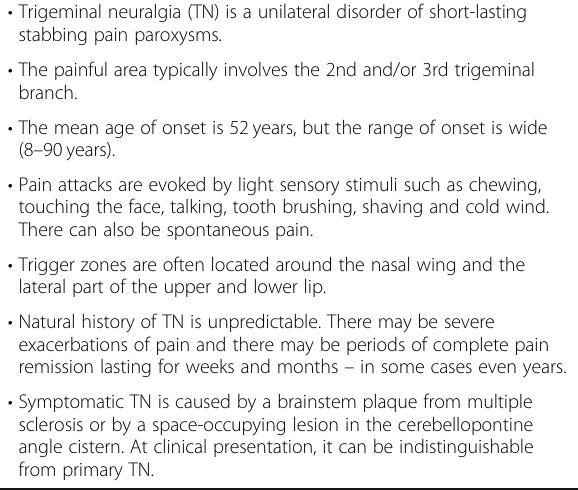
Table 19 Clinical characteristics in trigeminal neuralgia